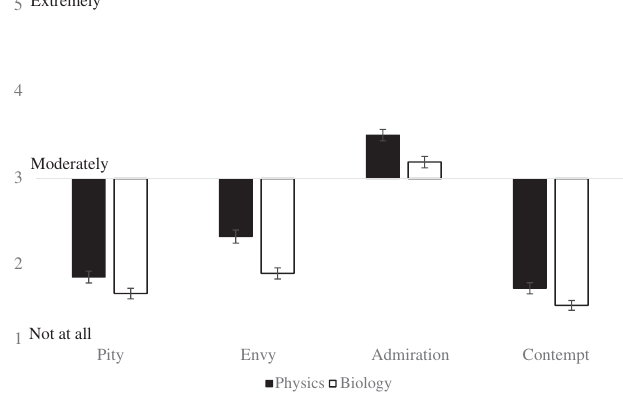
FIG. 3. Bar graph of emotions towards scientists. The error bars represent standard error. See Table IV for sample sizes.